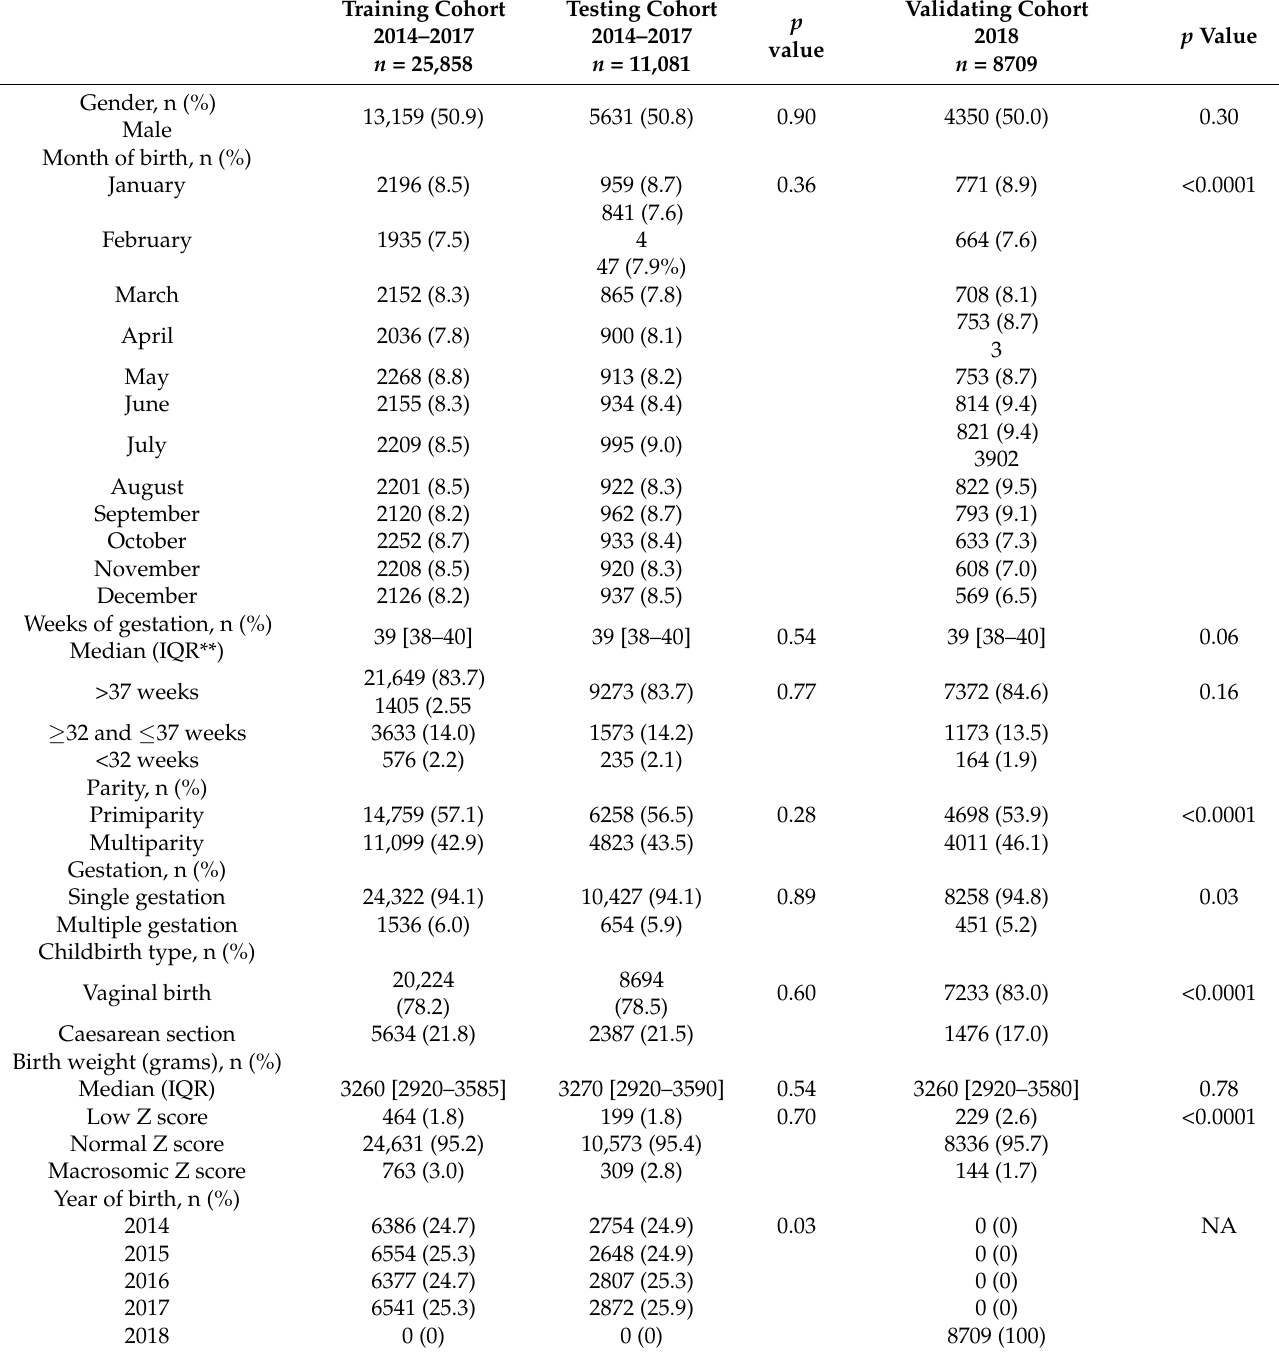
Table 1. Demographic and clinical characteristics of the training, testing, and validating